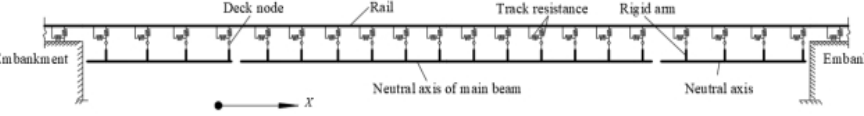
Figure 3. Analytical model of beam–rail system.